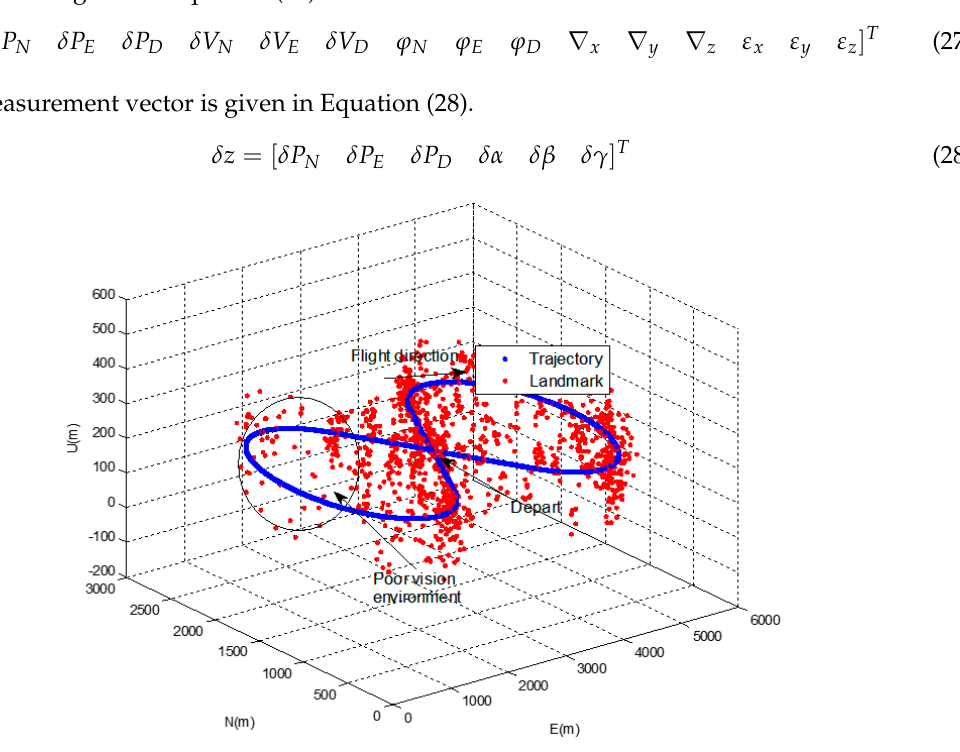
Figure 4. Vehicle trajectory and landmarks in simulation.